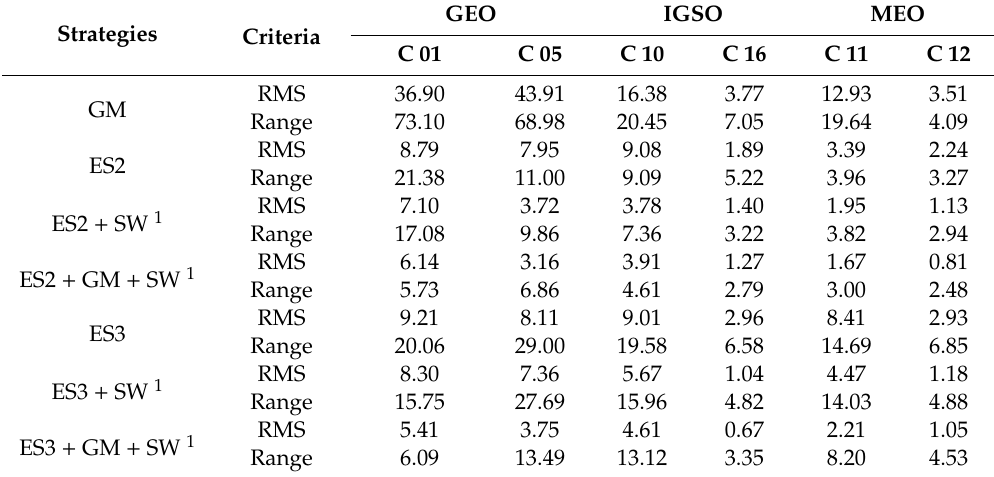
Table 4. Statistics of the di ff erent models for 24 prediction (ns).